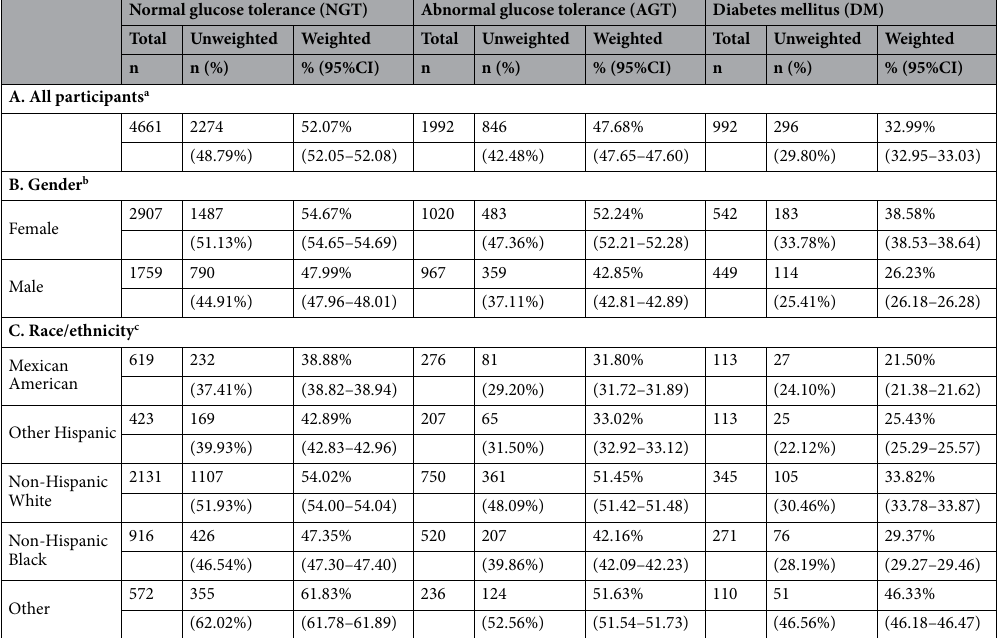
Table 5. Body mass index-standardized seropositivity rates (%, with 95% confidence intervals [CI]) after hepatitis B vaccination, separated by glucose tolerance state. a P < 0.0001 for the weighted percent among three glucose tolerance states. b P < 0.0001 for weighted percent between both genders in all three states of glucose tolerance and for weighted percent among three states of glucose tolerance in both genders. c P < 0.0001 for weighted percent between among 5 racial/ethnic groups in all three states of glucose tolerance and for weighted percent among all three states of glucose tolerance in all 5 racial/ethnic